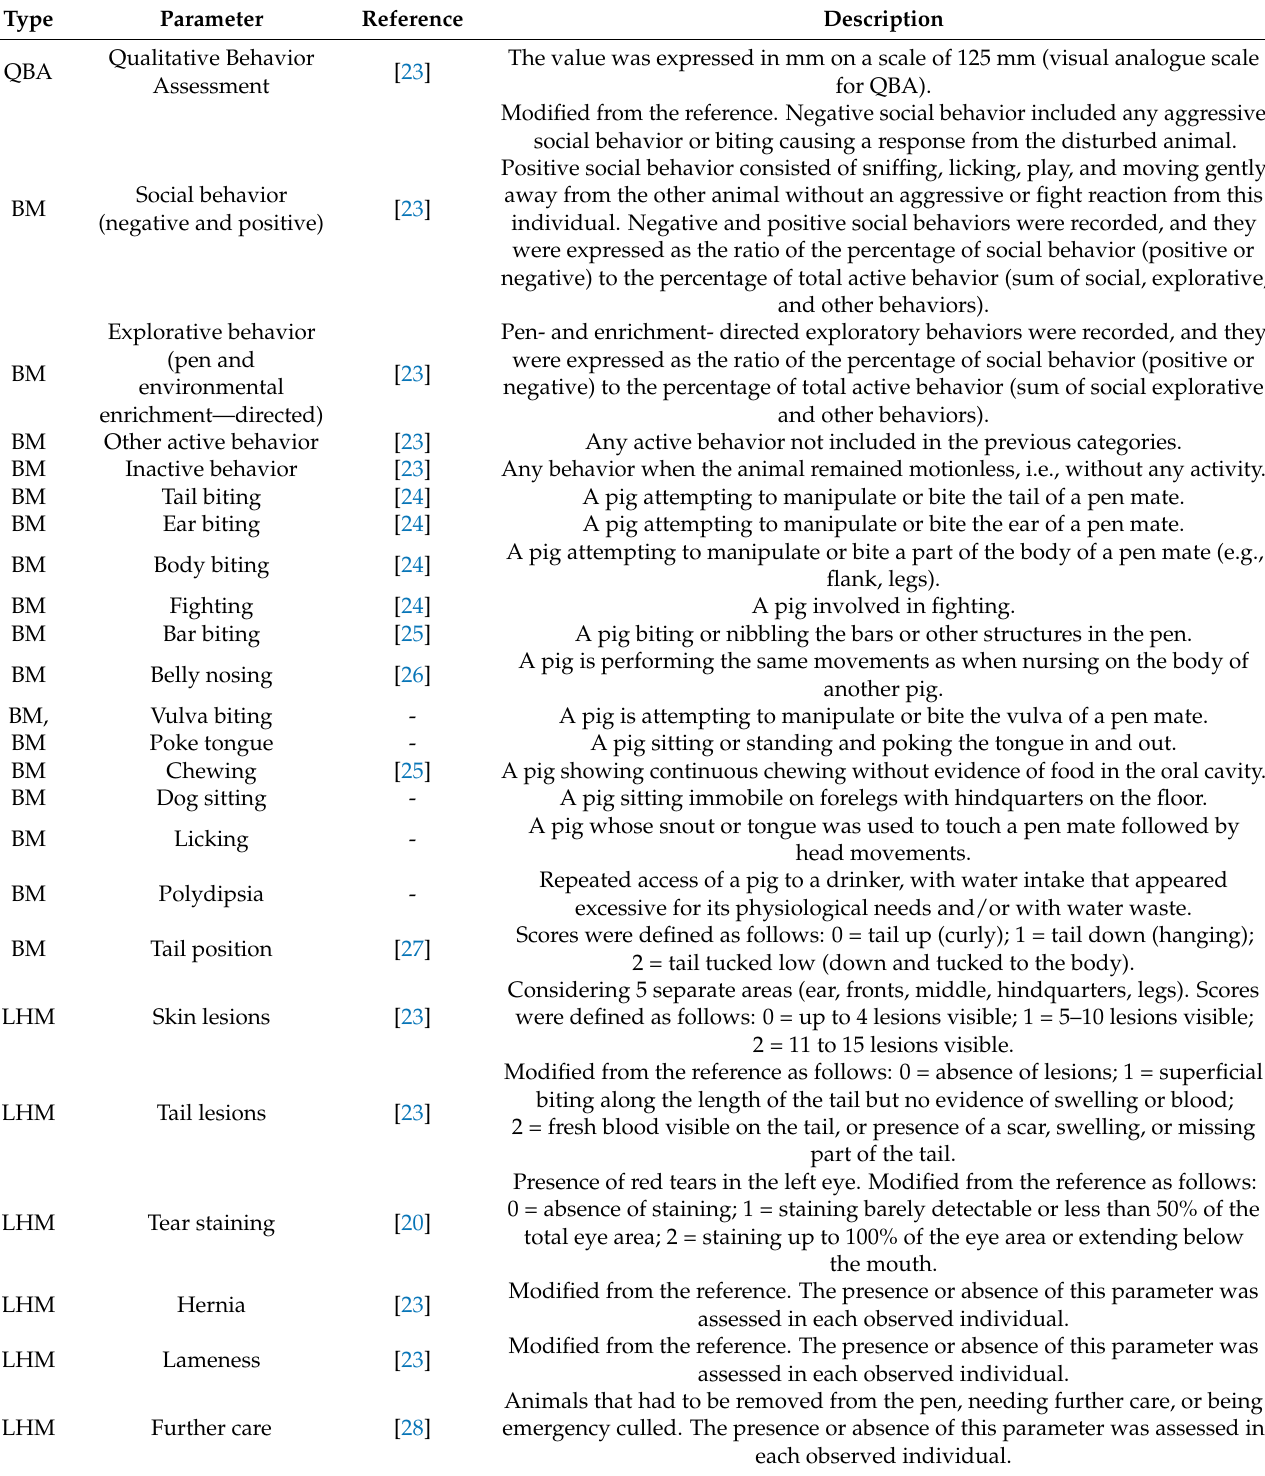
Table 1. List of parameters measured in the study, as well as their level of sampling, references, and